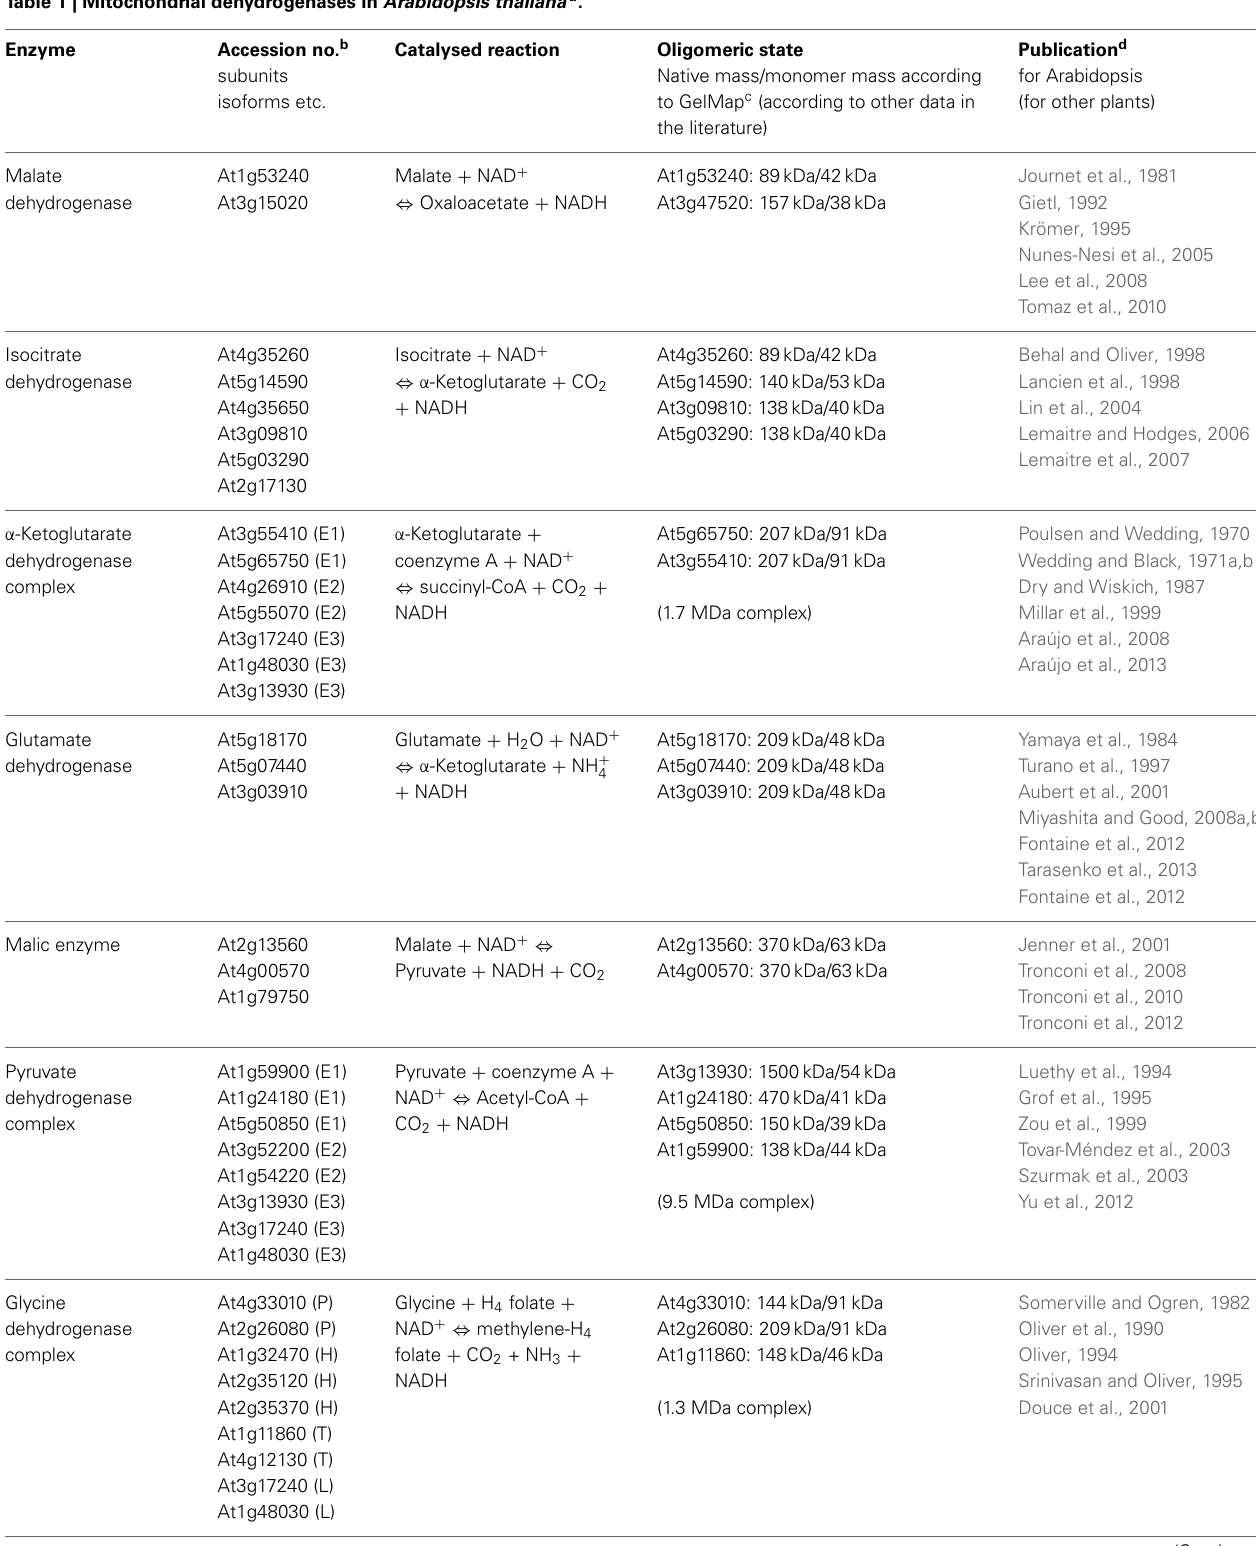
Table 1 | Mitochondrial dehydrogenases in Arabidopsis thaliana a